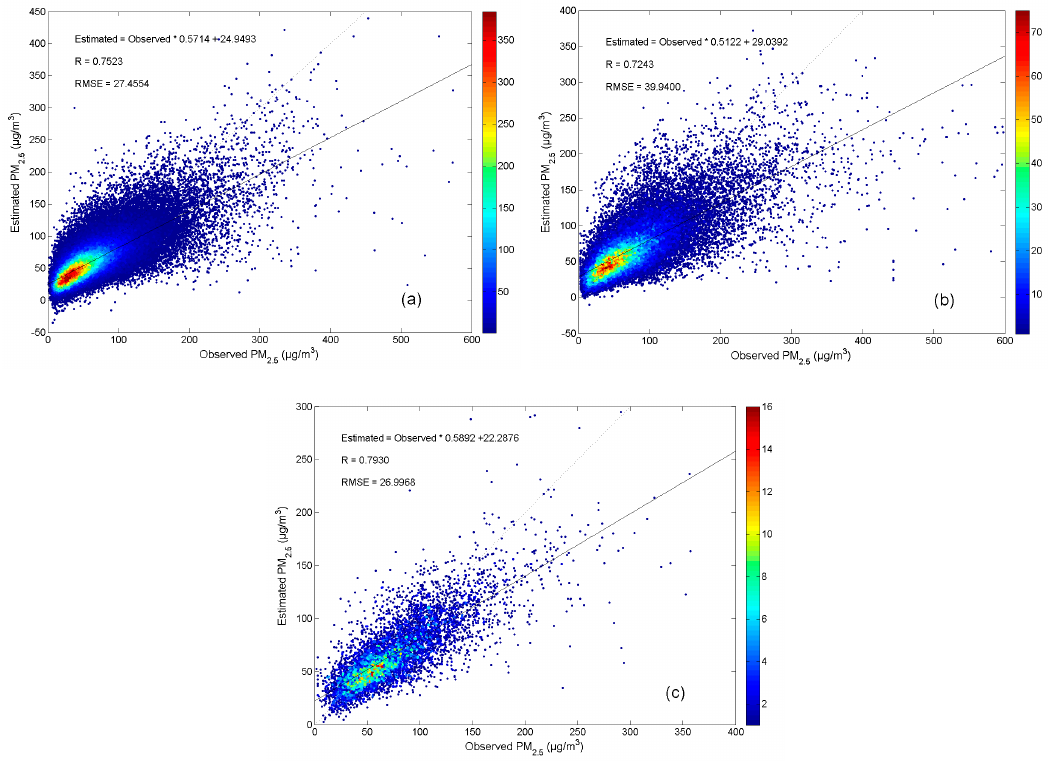
Figure 2. ( a ) Scatter maps of model cross-validation result, ( b ) model prediction result, and ( c ) model 17-day prediction result.